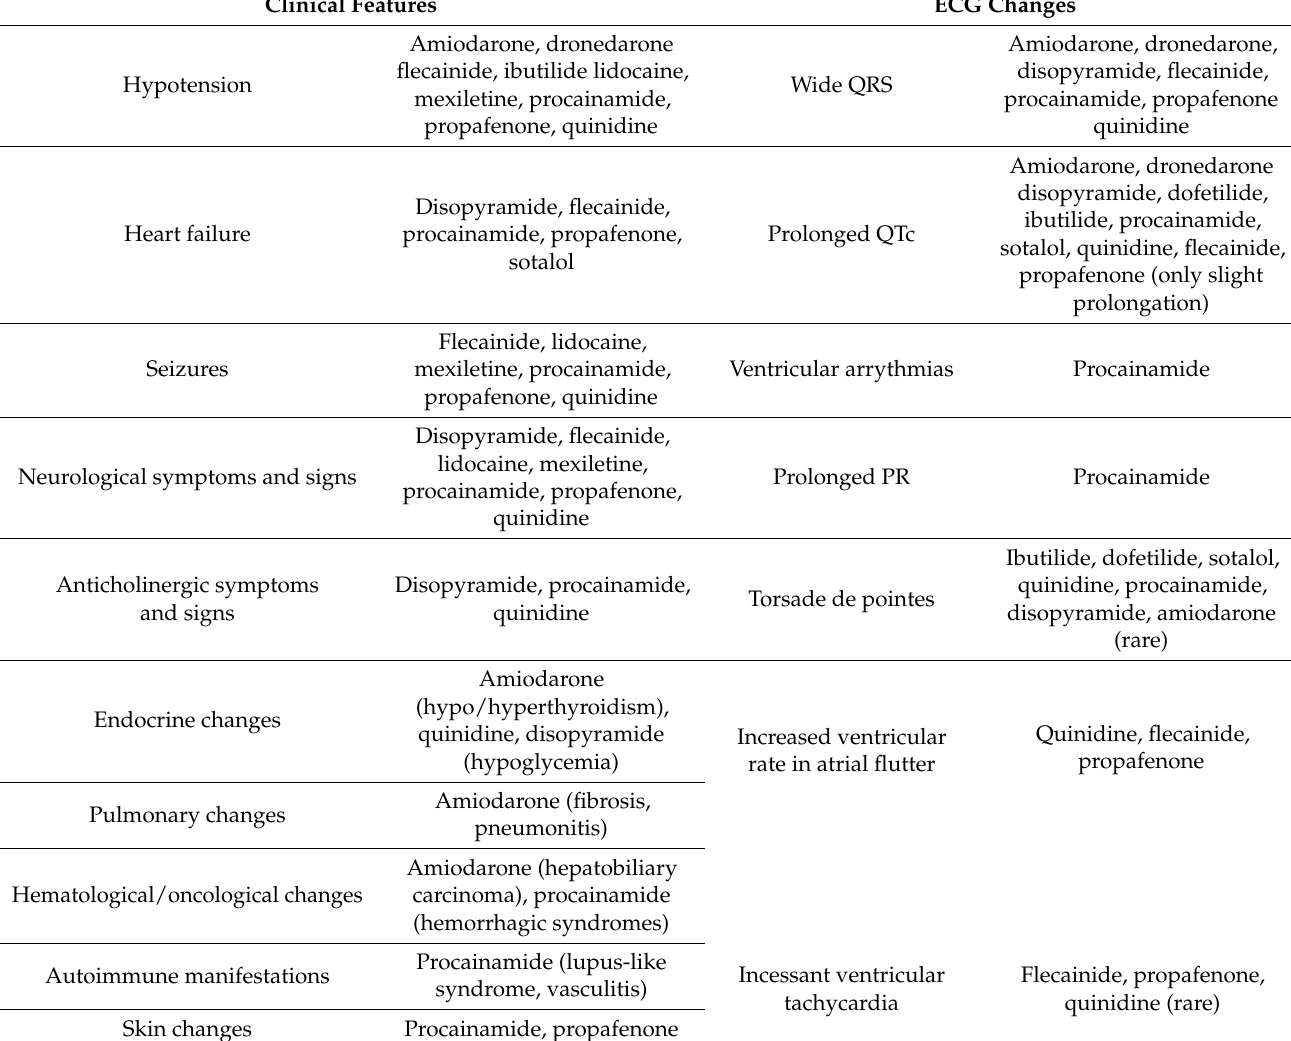
Table 3. Antiarrhythmic drugs toxicity (adapted from